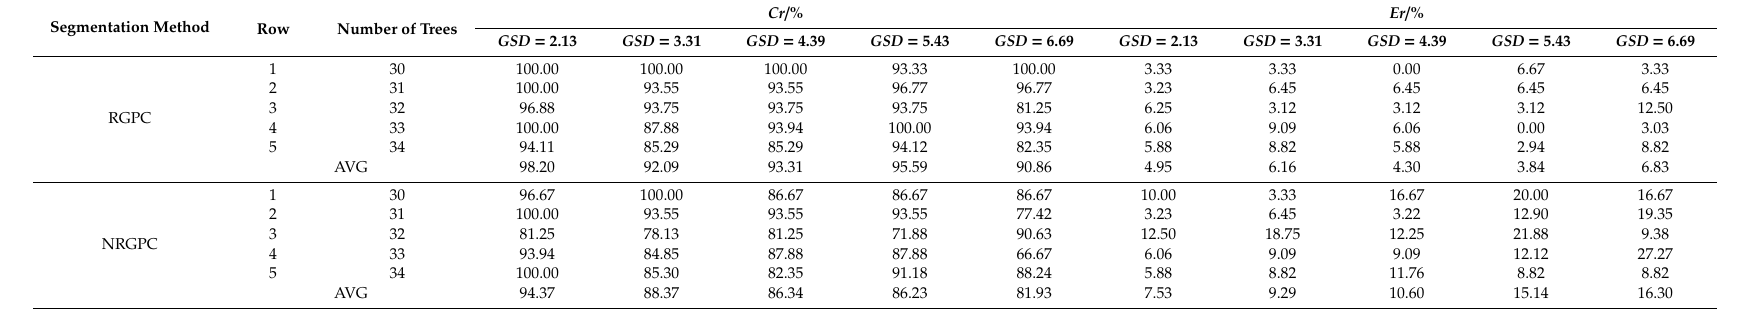
Table 2. Column detection results of the orchard point-cloud